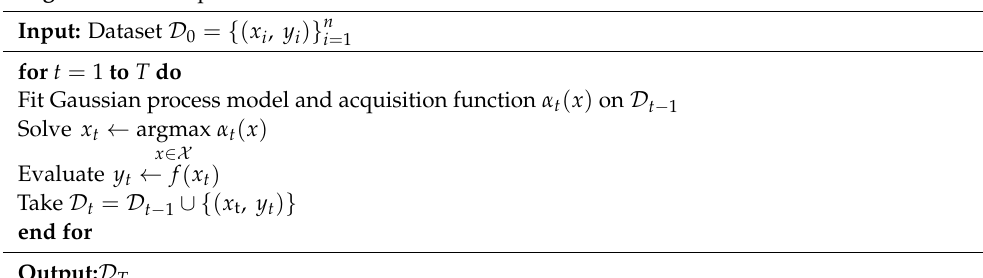
Algorithm 1. The pseudocode of